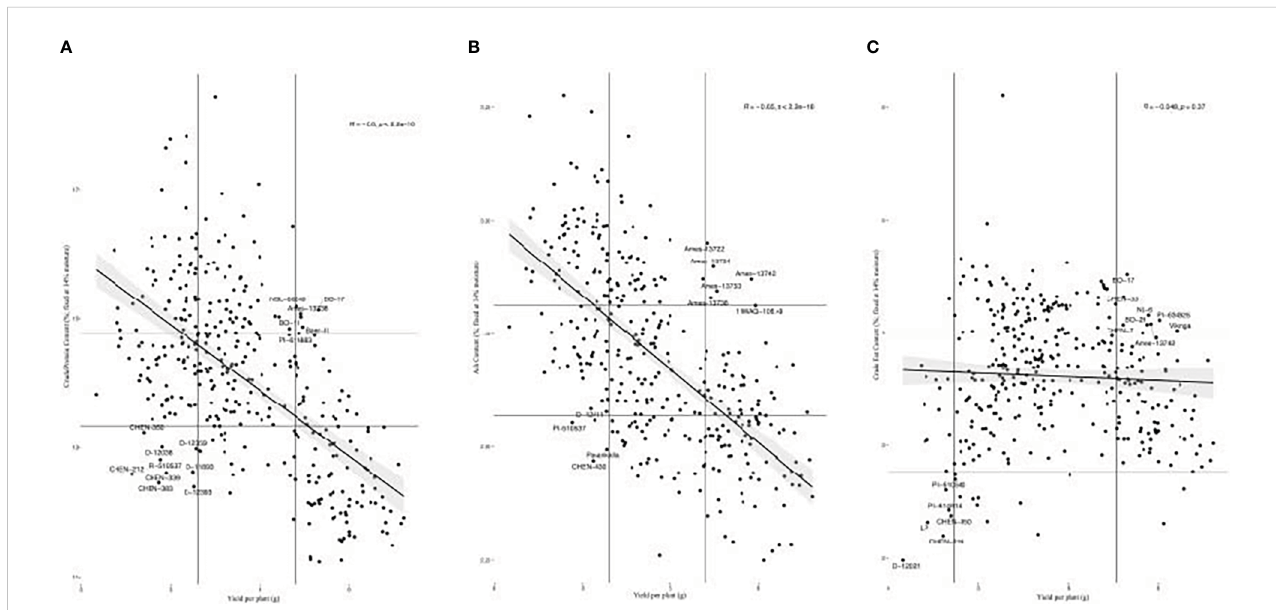
FIGURE 6 (A) Scatter plot of accession best linear unbiased estimate values for crude protein content by yield per plant. Accessions in the top 30% or bottom 30% of values for both traits are labeled, as shown within the vertical and horizontal lines at the corresponding quantiles. (B) Scatter plot of accession best linear unbiased estimate values for ash content by yield per plant. Accessions in the top 30% or bottom 30% of values for both traits are labeled, as shown within the vertical and horizontal lines at the corresponding quantiles. (C) Scatter plots of accession best linear unbiased estimate values for crude fat content by yield per plant. Accessions in the top 25% or bottom 5% of values for both traits are labeled, as shown within the vertical and horizontal lines at the corresponding